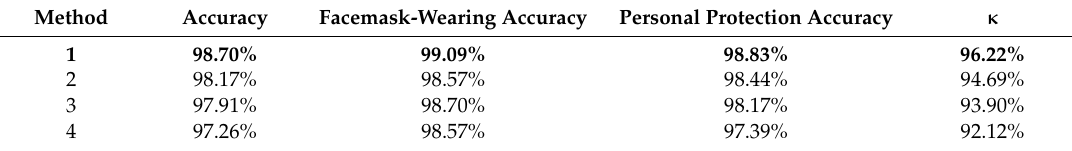
Table 6. Ablation experiment of super-resolution and classification networks